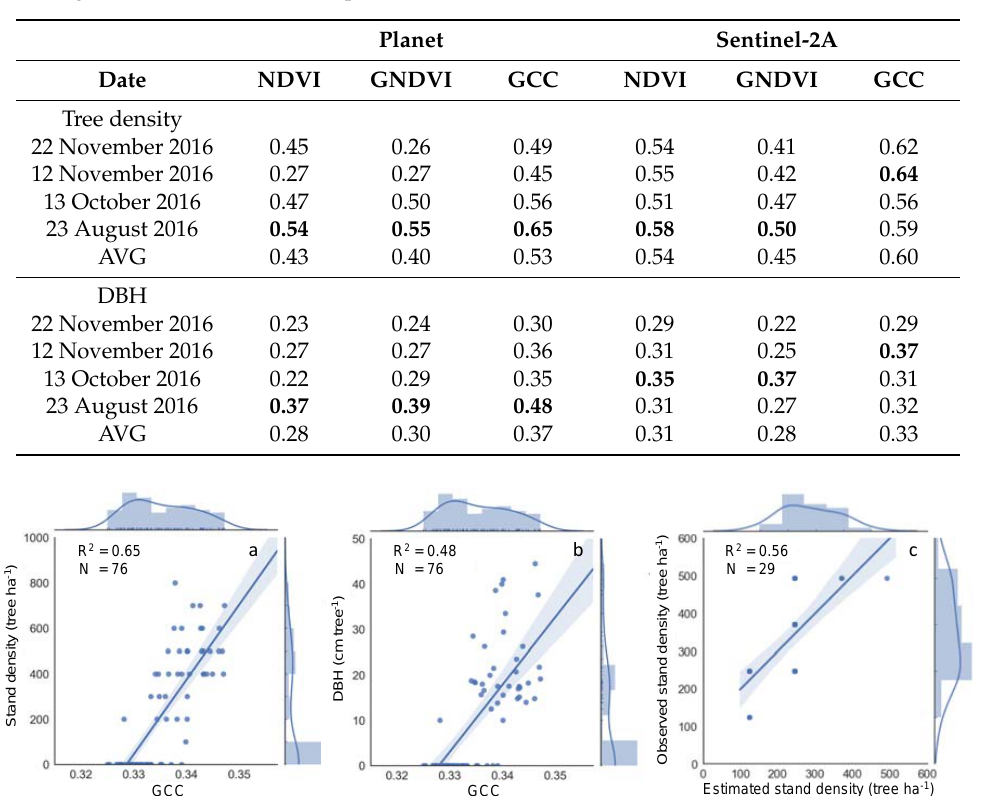
Table 4. R 2 of the correlation between the three VIs (NDVI, GNDVI and GCC; see Table 2) and stand density and DBH measured at the field survey. VIs were correlated with stand density and DBH using four images taken at different dates prior to fire. Best correlations are indicated in bold. Planet